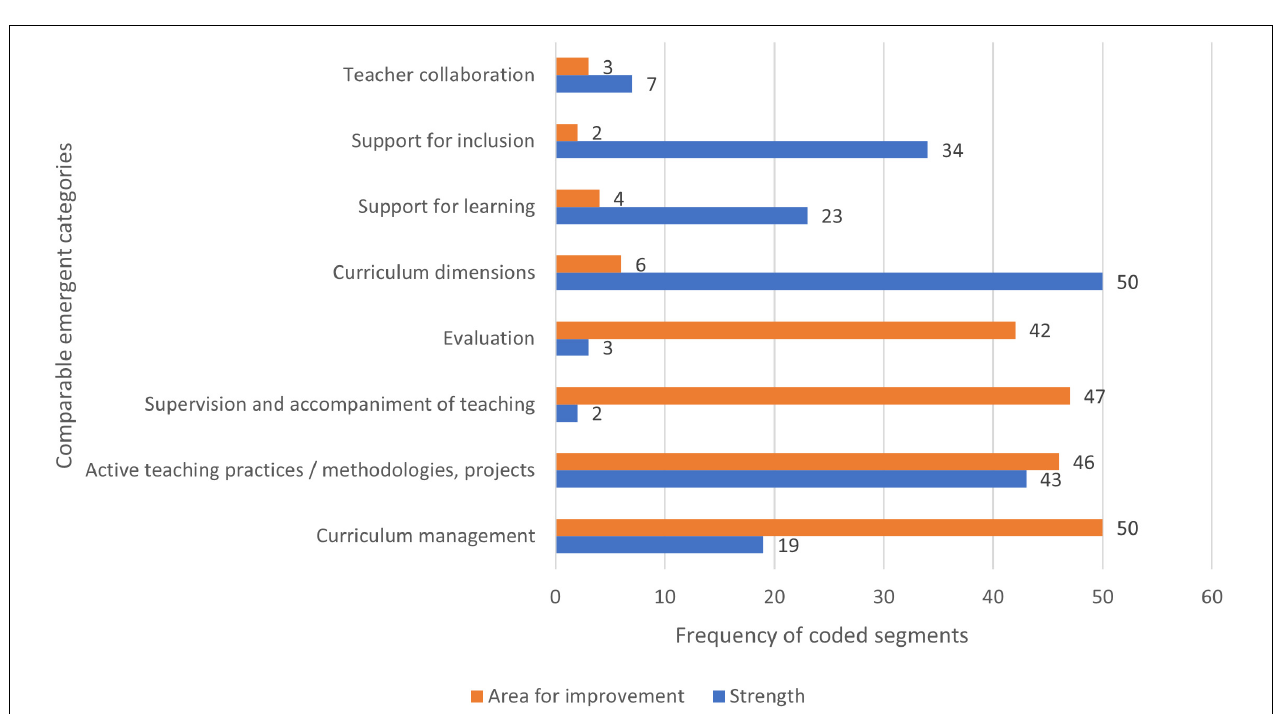
FIGURE 8 | Provision of educational service: areas for improvement. The distribution of coded segments by subcategories, year, and TA.